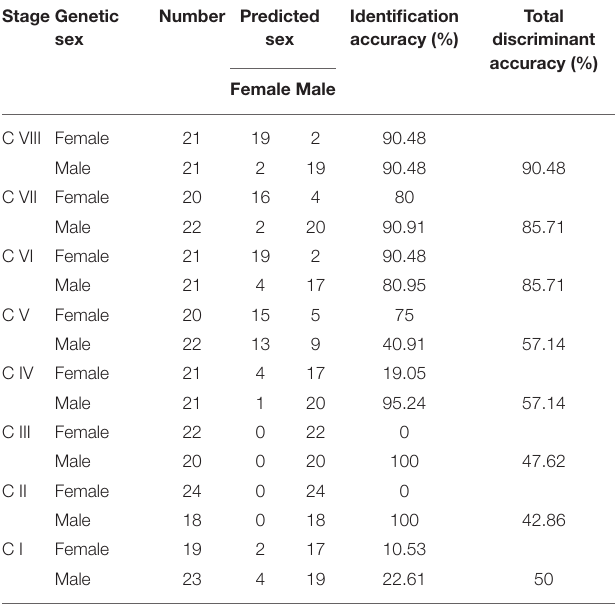
TABLE 5 | The accuracy of sex identification at different stages of the S . paramamosain crablets. Stage Genetic